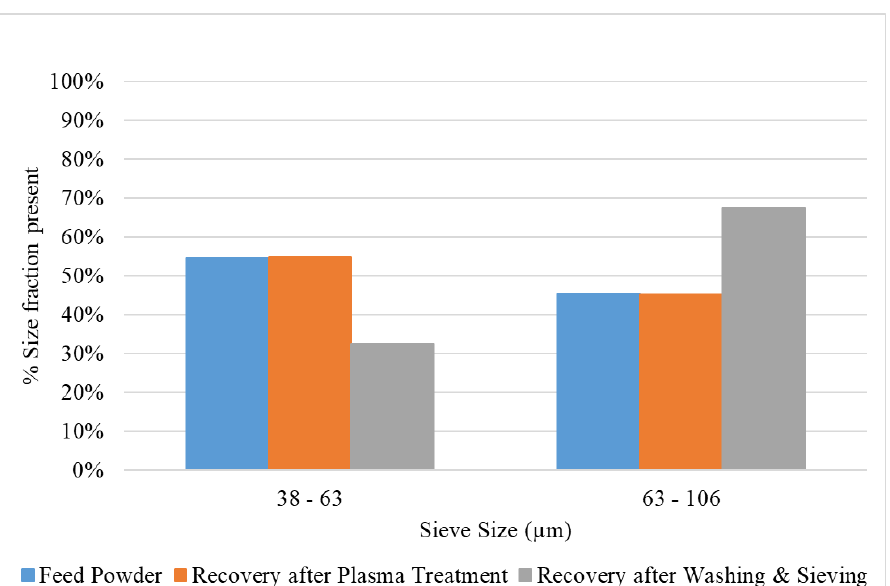
Figure 4. Size fractions of the powder present in the feed after plasma treatment and after cleaning and